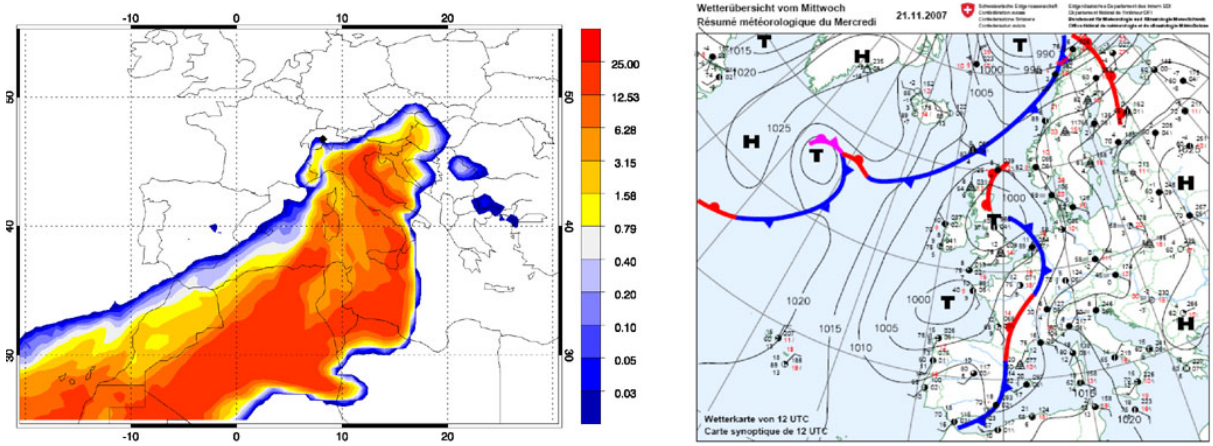
Fig. 8. Relative footprint map of trajectories corresponding to high CO 2 concentration (extreme event, case 2) measured on 23 November 2007 (left). See Fig. 7 for explanation of the color legend. South Foehn situation on 21 November (right) as represented in the daily surface weather analysis of MeteoSwiss (available from http://www.meteoschweiz.admin.ch/web/de/wetter/wetterrueckblick.html)